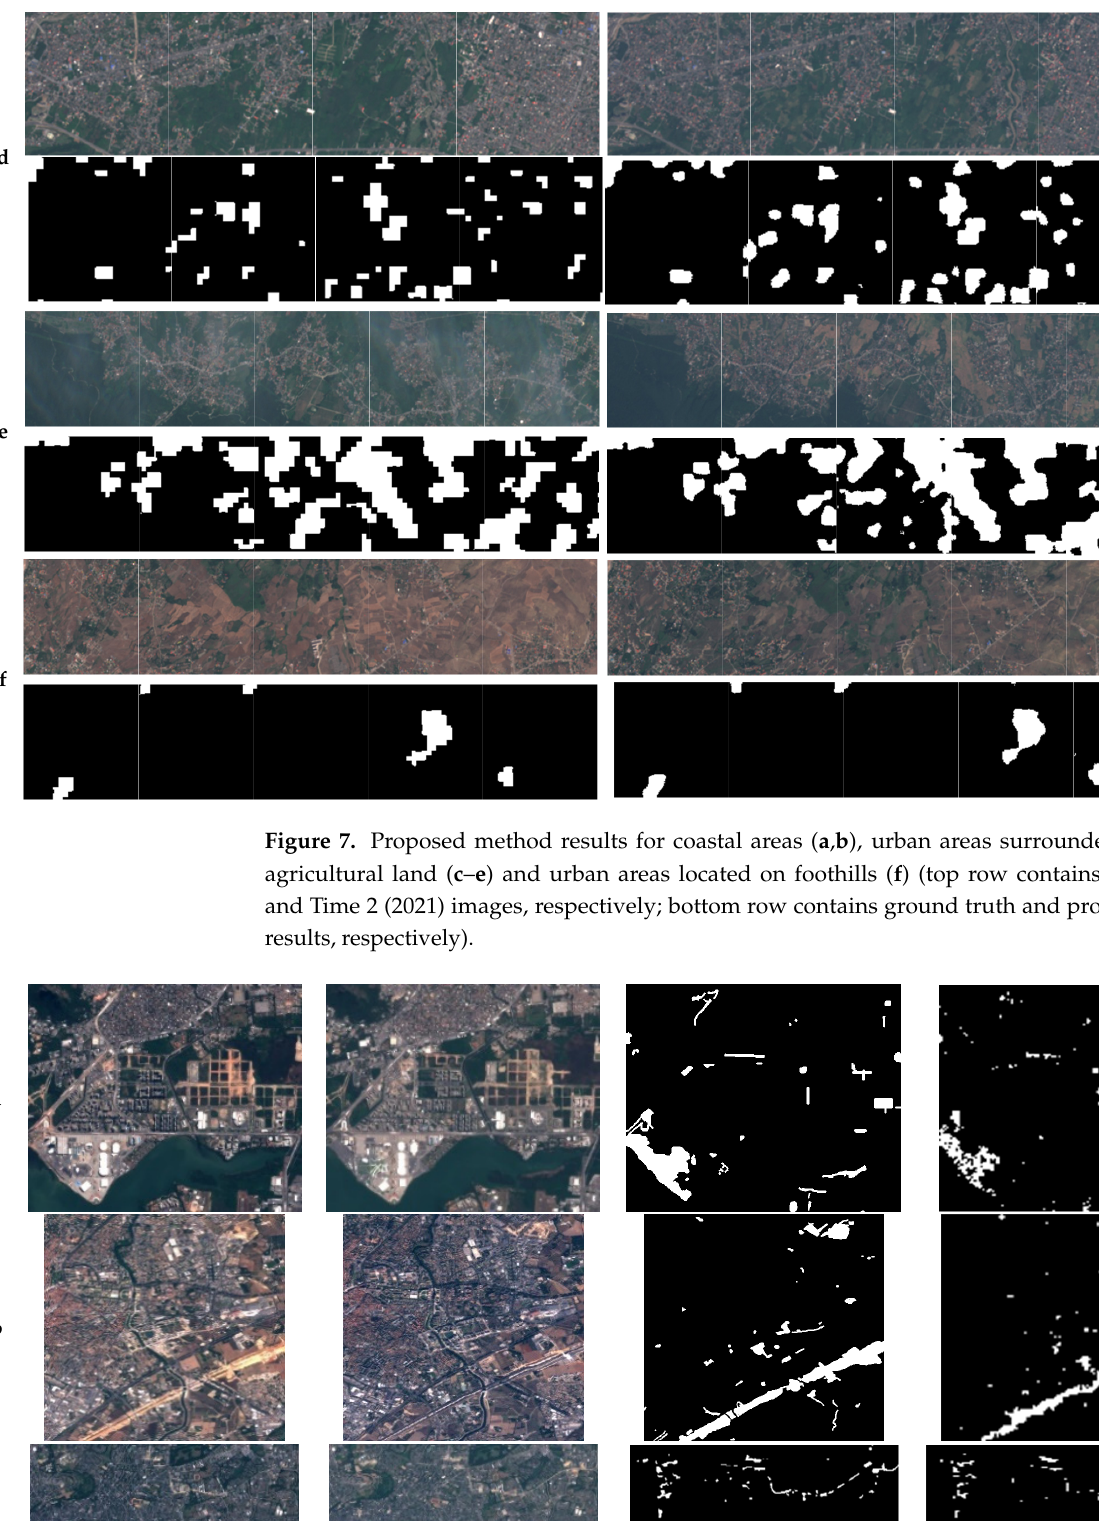
Figure 8. Results of the proposed method in the cities of Rio ( a ), Montpellier ( b ), Rennes ( c ), Chong ‐ qing ( d ), and Beihai ( e ) (from left to right: Time 1 image, Time 2 image, ground truth, and proposed method results). Figure 9 compares the performance of STCD ‐ EffV2T Unet with other EffV2 networks. It shows five coastal ports (a–e), five urban areas covered or surrounded by forest or ag ‐ ricultural land (f–j), and two urban areas located on foothills (k and l). These 12 areas are in the north of Iran. Among the EffV2 series, EffV2B3 and EffV2B2 can detect changes nearly properly; however, the STCD ‐ EffV2T Unet can detect changes more accurately. As shown by Figure 9, the STCD ‐ EffV2T Unet can preserve the edges and shapes of changes. There is the highest similarity between STCD ‐ EffV2T Unet results and the ground truth.